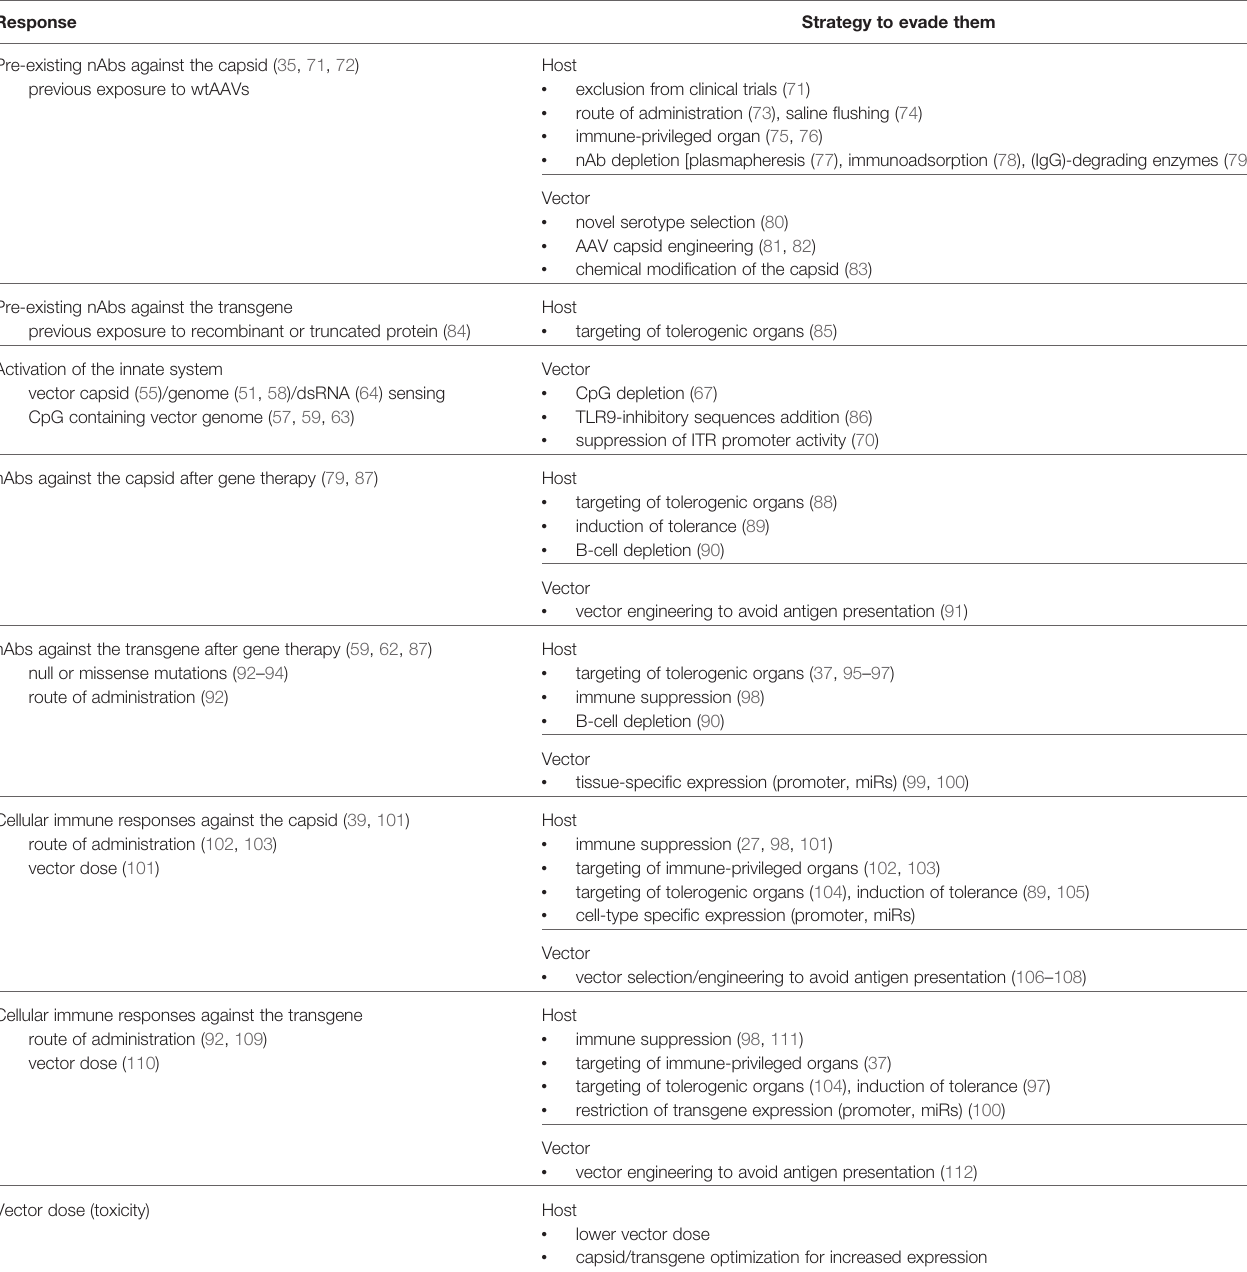
TABLE 1 | Summary of immune responses to AAV gene therapy and evasion/prevention strategies. Response Strategy to evade